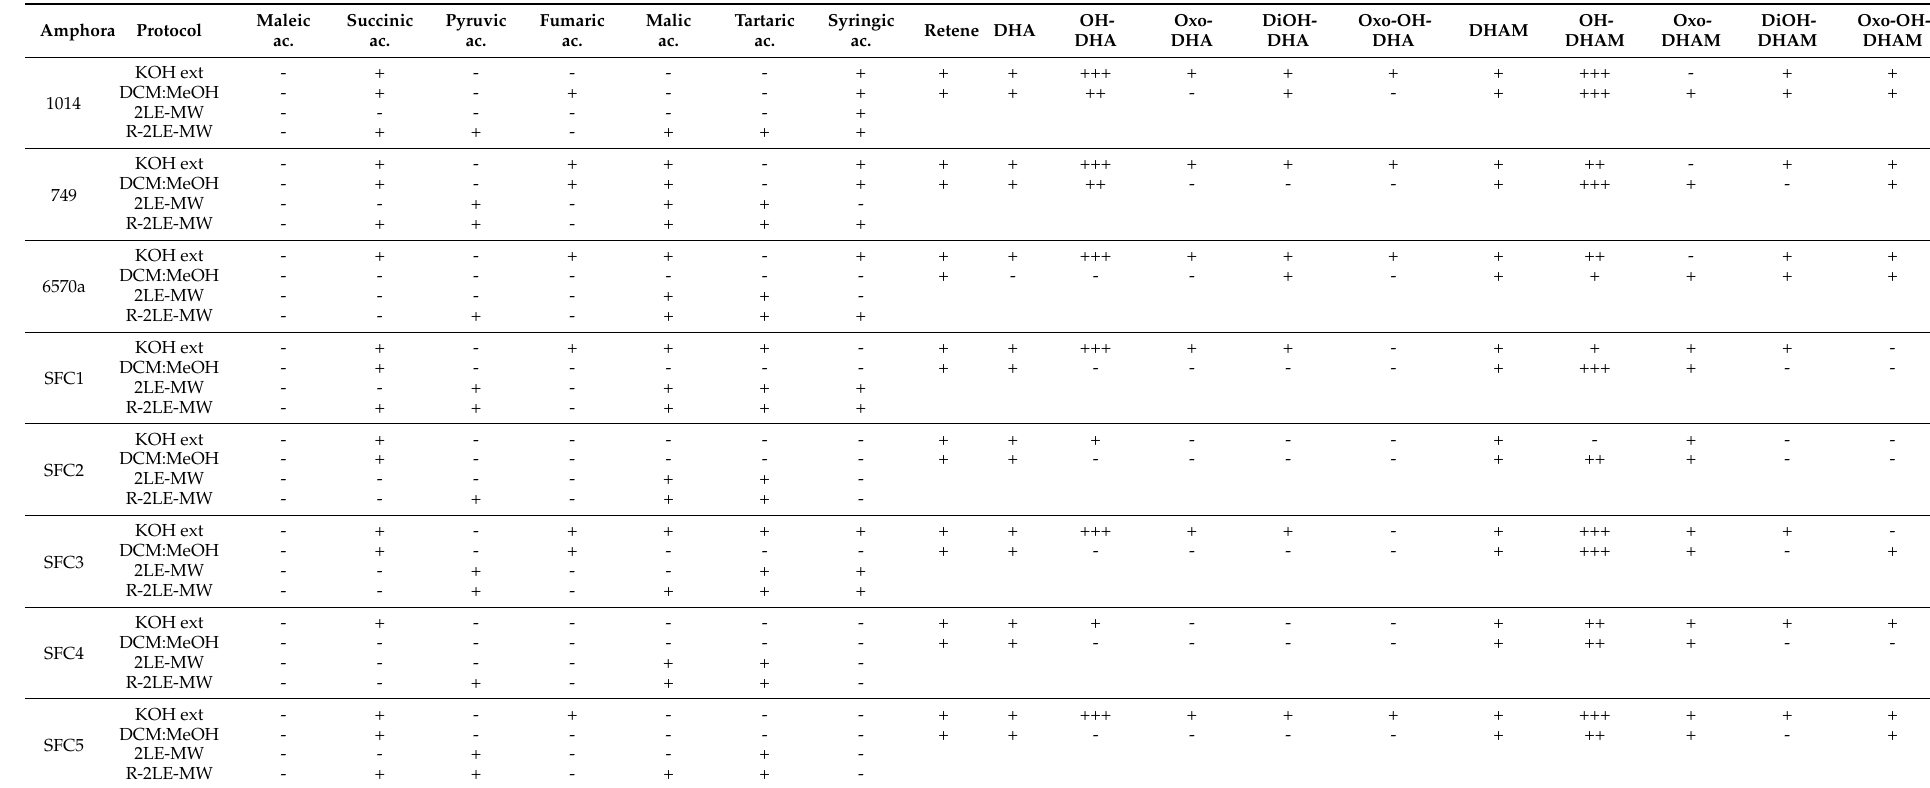
Table 3. Molecules identified in pitch coatings. Presence (+) and absence (-) of molecular markers under alkaline fusion (KOH ext.), organic extraction with DCM:MeOH, butylation applied on the remaining fraction (2LE-MW) or applied directly on the pitch (R-2LE-MW). The number of ‘+’ refers to the number of molecules present. ac.: acid; OH-DHA: hydroxy-DHA (i.e., 3-hydroxy-DHA; 7-hydroxy-DHA and 15-hydroxy-DHA); Oxo-DHA: 7-oxo-DHA; DiOH-DHA: 7,15-dihydroxy-DHA; Oxo-OH-DHA: 7-oxo-15-hydroxy-DHA. DHAM and oxidized derivatives (OH-DHAM, Oxo-DHAM, DiOH-DHAM and Oxo-OH-DHAM) refer to the same skeleton with methyl ester derivatives instead of the acid